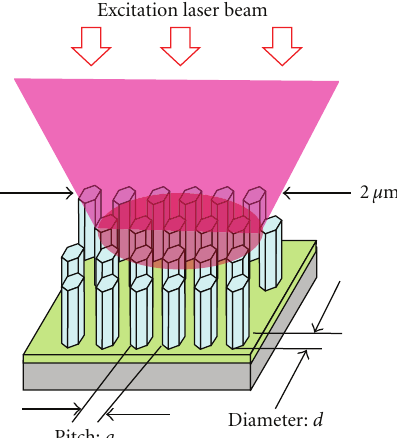
Figure 3: Schematic of substrate with nanowires irradiated by laser beam for PL